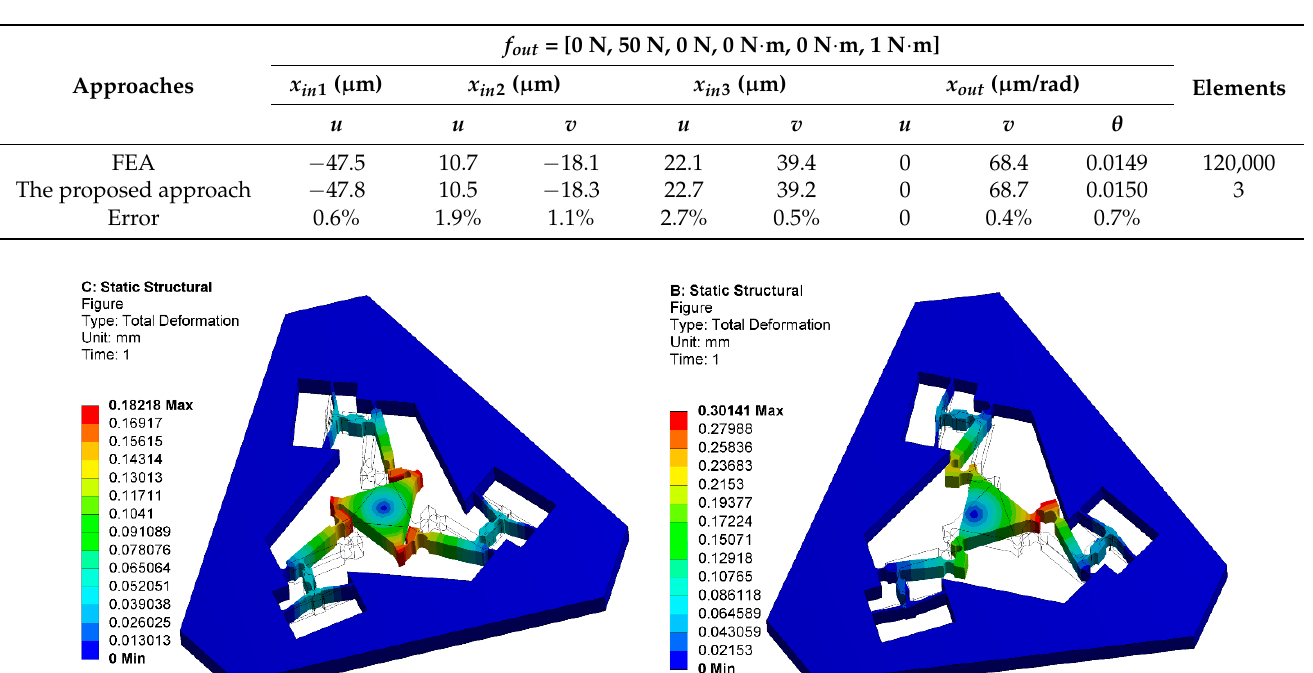
Table 4. The input/output displacements under the output force of f out = [0 N, 50 N, 0 N, 0 N · m, 0 N · m, 1 N · m].